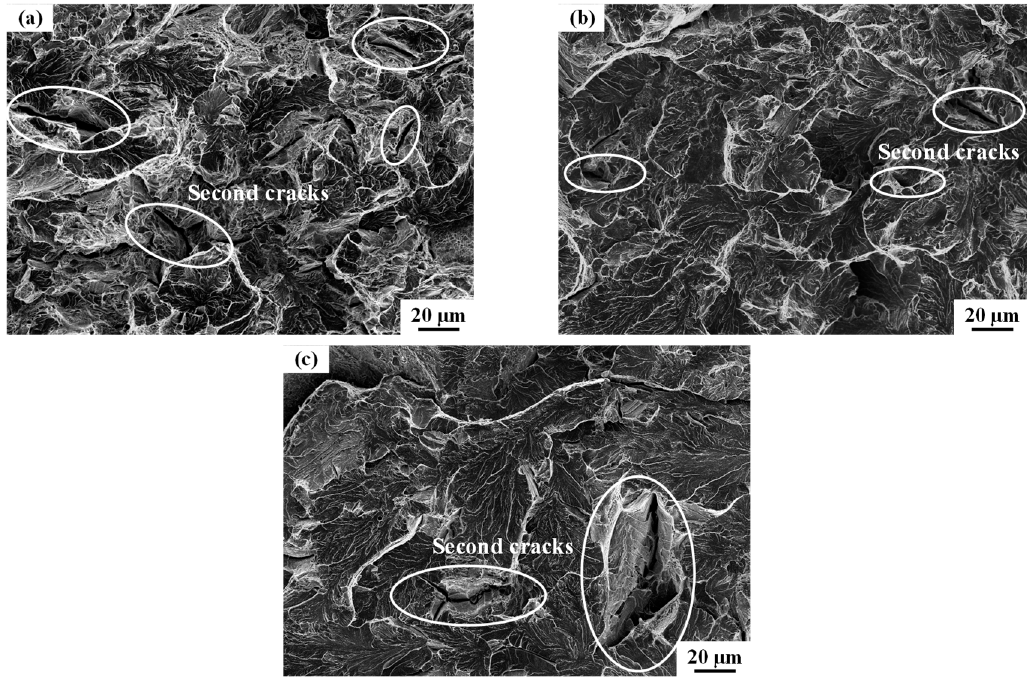
Figure 6. Fracture morphology of tensile samples at different austenitizing temperatures: ( a ) 880 °C; ( b ) 1020 °C; and ( c ) 1200 °C.